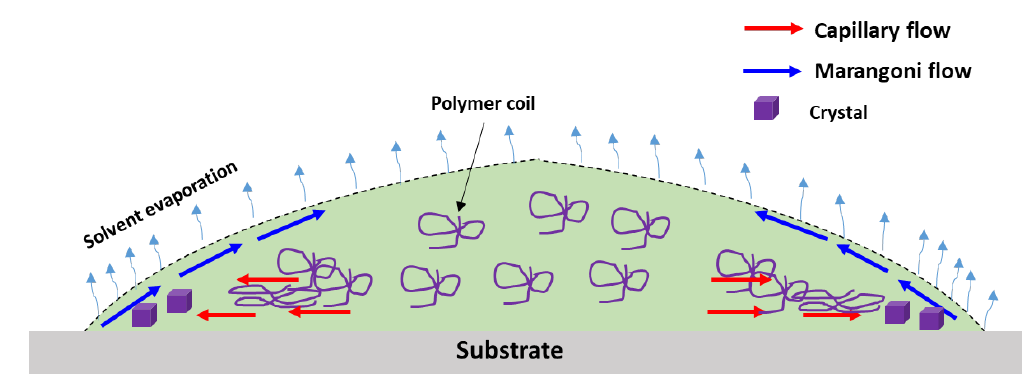
Figure 10. Schematic illustration of solvent evaporation-induced flows and crystallization of PVDF droplet during solvent evaporation.